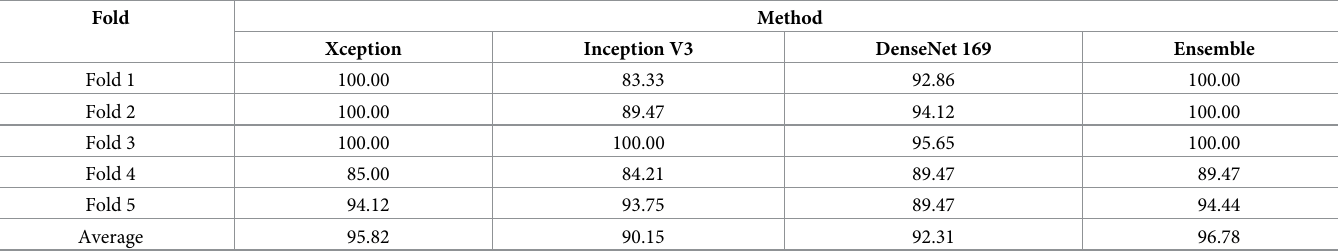
Table 4. Fold wise recall scores concerning the base models and the ensemble method. All scores are reported in %.